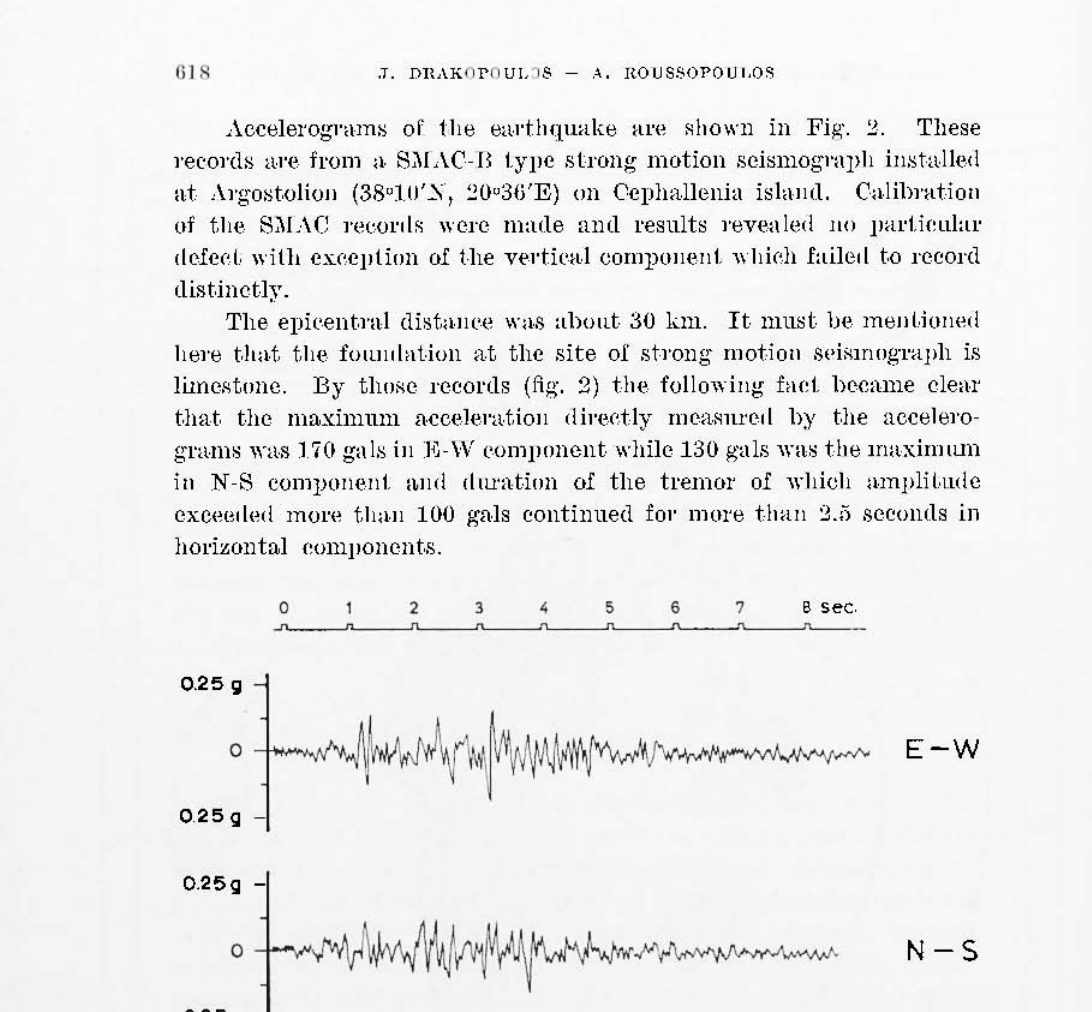
(fig. 3). 111 :\fesologhi (38 0 3U'N, 21o Ji)'E) and Zant.e 37 o·l-i)'N, 20°i)6'B) t.he reeOl'ding l1en 01 the seiHllloHcoj)es defleeLed by 2.5 mm in }.l150oE and ~20oE,